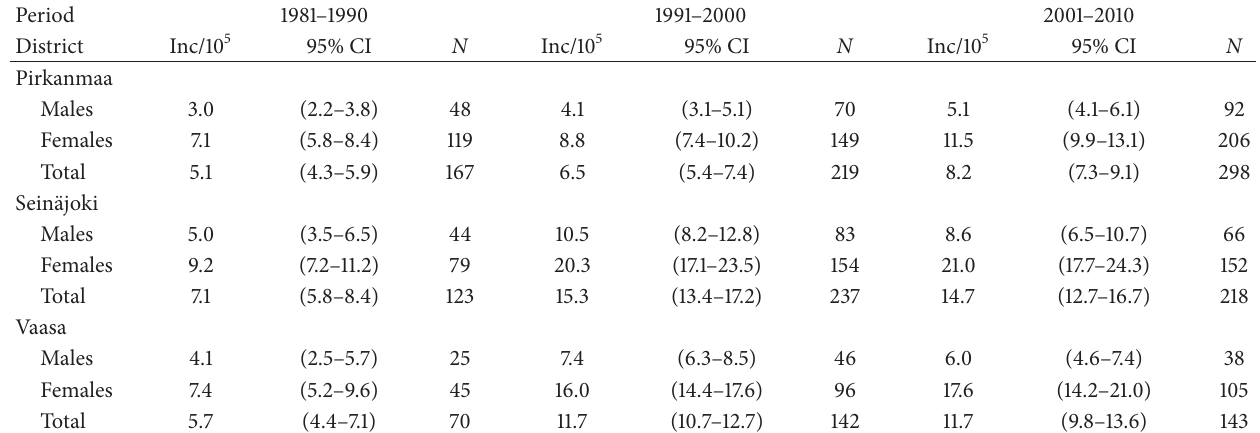
Table 3: Incidence of MS during the three decades examined in Pirkanmaa, Sein¨ajoki, and